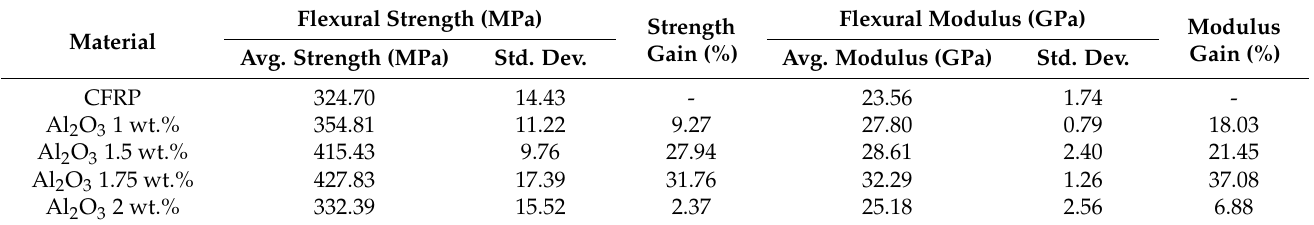
Table 6. Flexural behavior of neat and hybrid Al 2 O 3 nanocomposites.